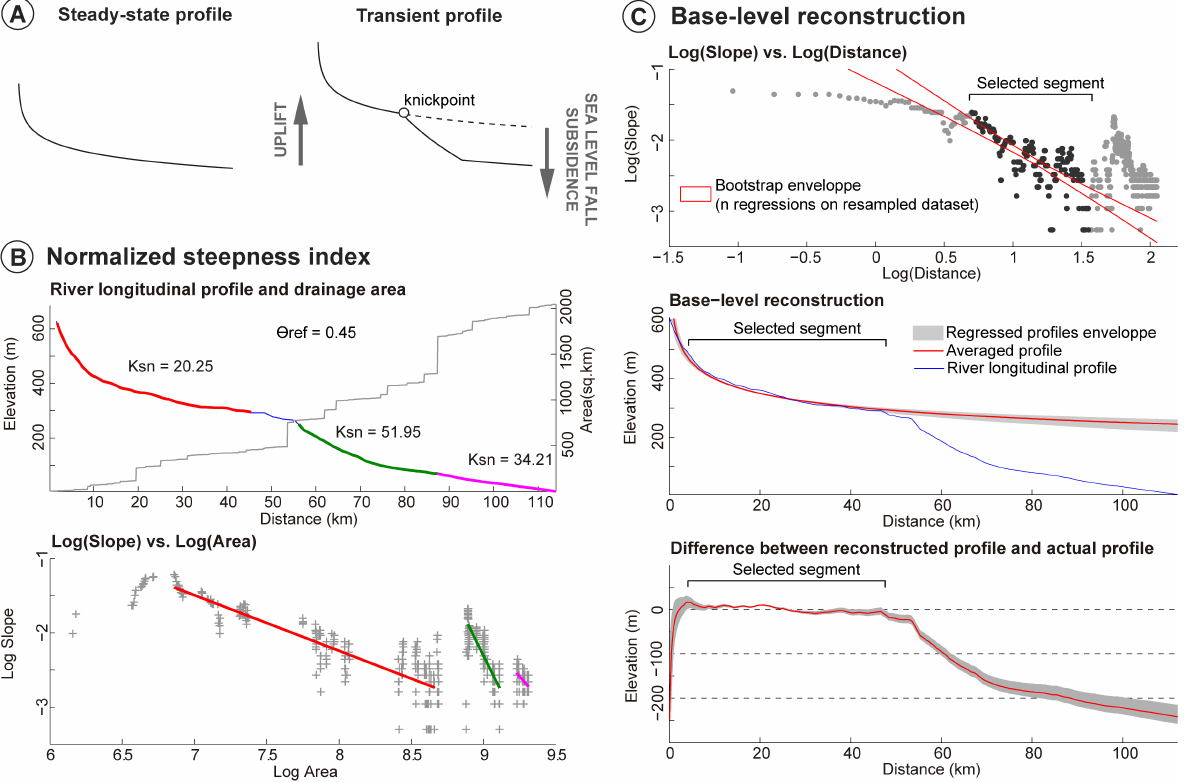
Figure 6. Analysis of river profiles. ( A ) Schematic river profiles corresponding to steady-state and transient states; ( B ) calculation of the normalized steepness index for a river profile and corresponding drainage area. Slope of log(Slope) vs. log(Area) scaling is the concavity index θ ; the y-intercept is the steepness index k . In this example, the normalized steepness s index k is calculated using a reference concavity of 0.45. ( C ) Reconstruction of the upper sn base-level of a transient river profile using linear regressions on subsets of the log(Slope) vs. log(Distance) plot (bootstrapping